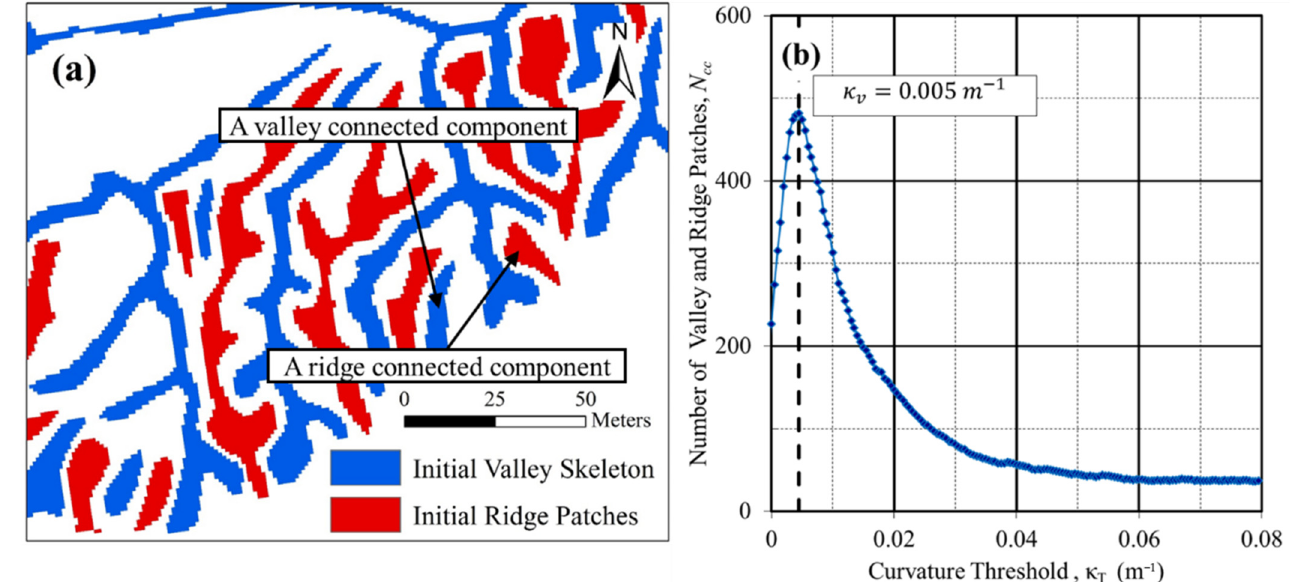
Figure 4. Valley differentiation: ( a ) Examples of connected components for valley and ridge and ( b ) the number of valley and ridge connected components ( N cc ) vs. curvature threshold ( κ T ) in the Isleta Drain watershed located in New Mexico. The peak value represents the transition from insignificant to significant convergence/divergence features ( κ v = 0.005 m − 1